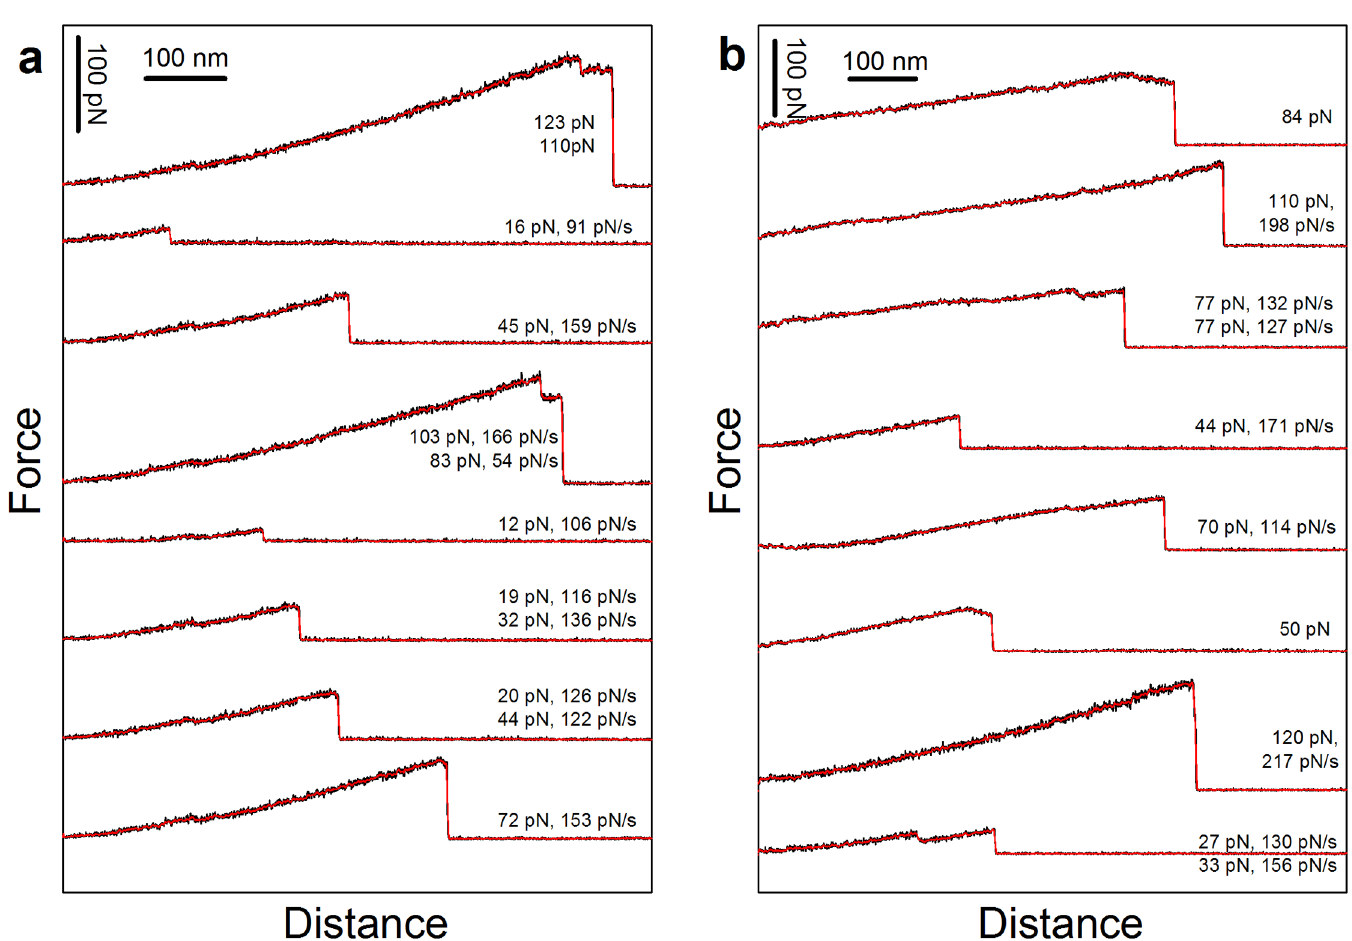
Fig 3. Examplesof typical force versus inter-beaddistancecurves obtainedfor (a) MUC1(Tn)–MGL interactionsand (b) MUC1(STn)–MGL interactions, respectively. Raw (black) and smoothed(red) data are shown. The curves were obtained when using the experimental conditions explainedin Fig 2A and 2B, respectively.For some of the curves successive rupture events can be identified(panela curve 1, 4, 6 and 7 from top, panel b curve 3 and 8 from top) whereasin others the high rupture forces and/or abnormalshapeof the force versus distancetrace prior to rupture are indications of the multiplicityof the rupture events. For some of the rupture events presenteda negativeincreasein the force prior to rupture, i.e. negativeforce loadingrates, are observed (panela curve 1 from top, panel b curve 1 and 6 from top). This is an abnormal behavior that can be explainedby a multiplicityof bonds being successively broken. For these observations the force loading rate is therefore not indicatedin the